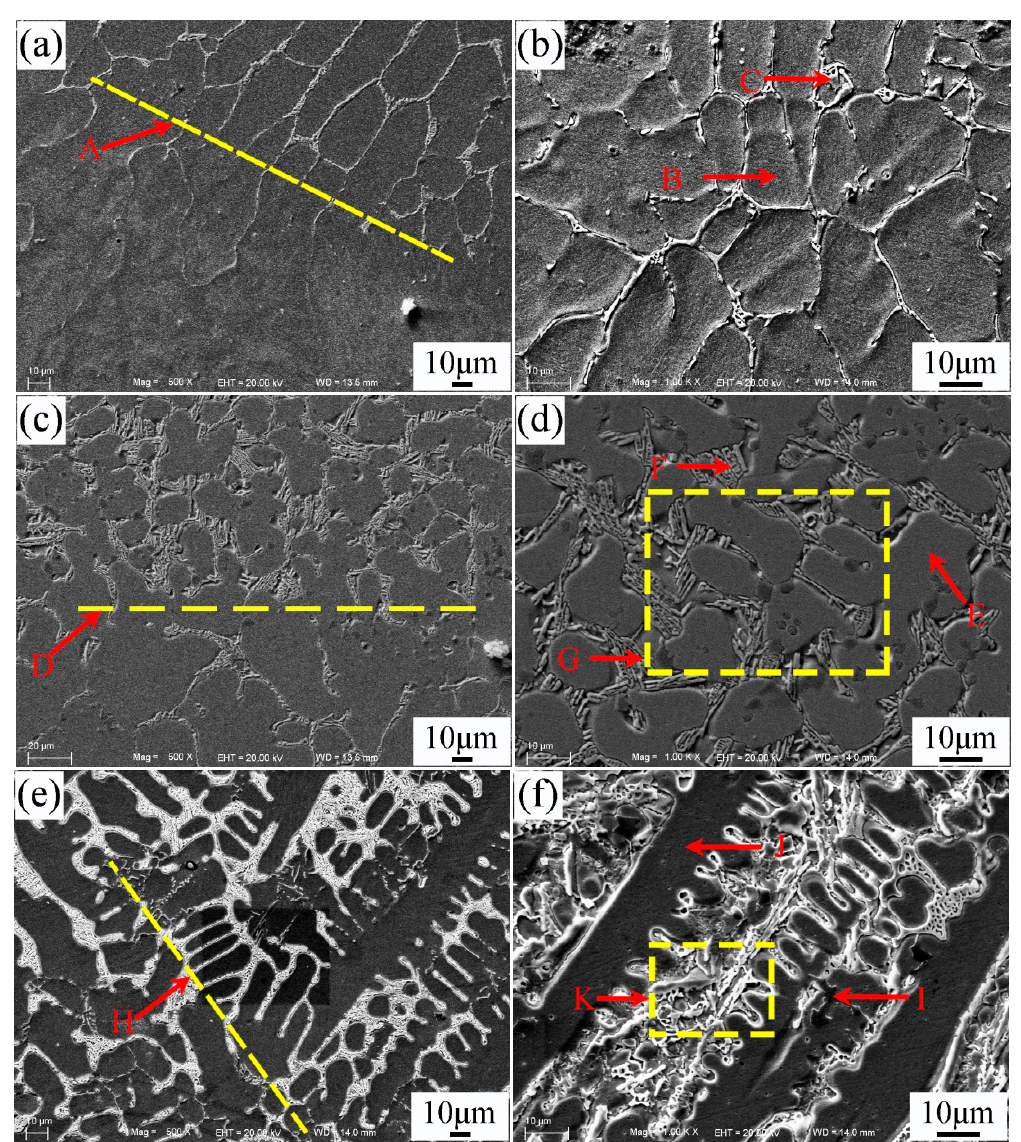
Figure 5. SEM of the interfacial zone of specimen No.2. ( a ) Heat affected zone; ( b ) Morphology of partly melted substrate; ( c ) Interface of melted substrate and coating; ( d ) Cellular grains and boundary precipitates; ( e ) Interface of cellular grains and dendrite grains; ( f ) Dendrite grains of the coating.